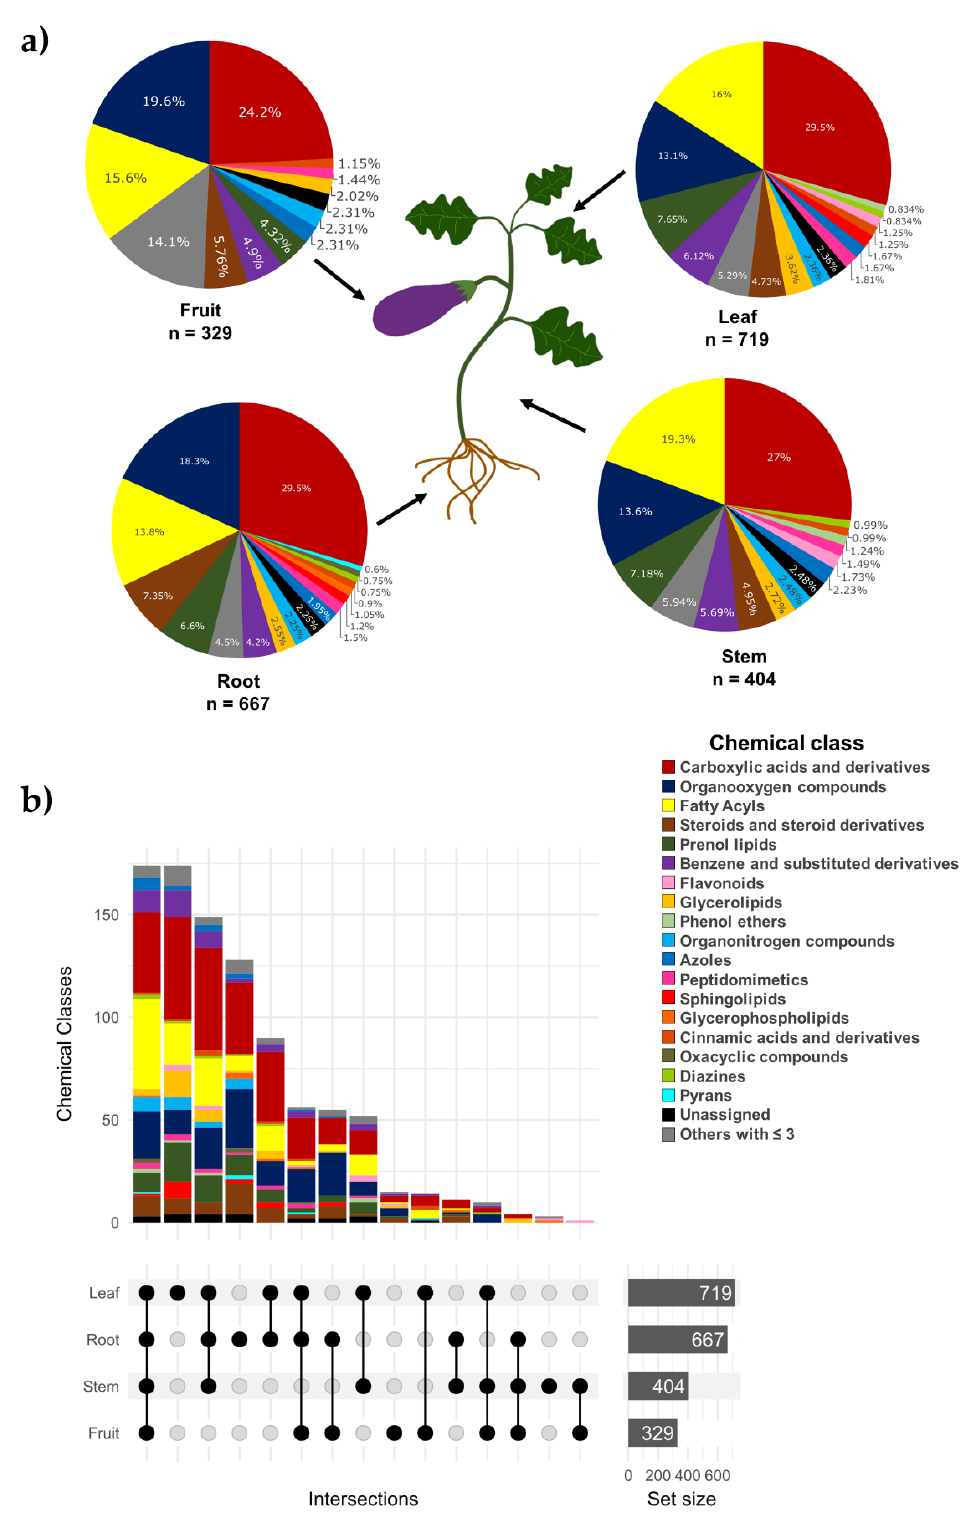
Figure 4. Metabolite chemical classes distributed in the different anatomical parts of eggplant residues. ( a ) Global chemical class pattern by site. ( b ) Specific overlapping pattern by site.